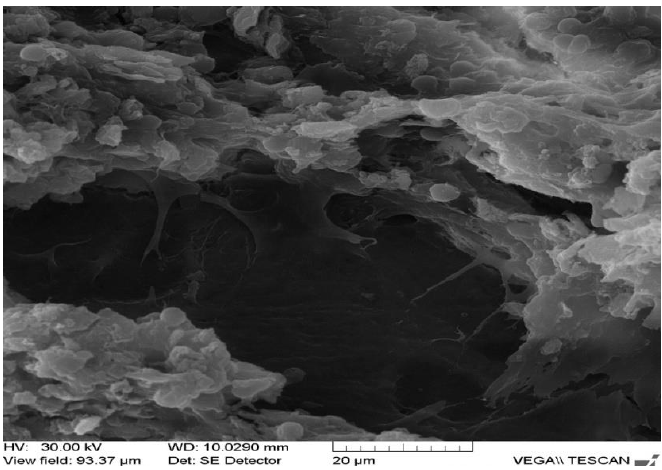
Figure 8. Pre-osseous substance deposited in excess in the area adjacent to the implanted material (Bio Aggregate).